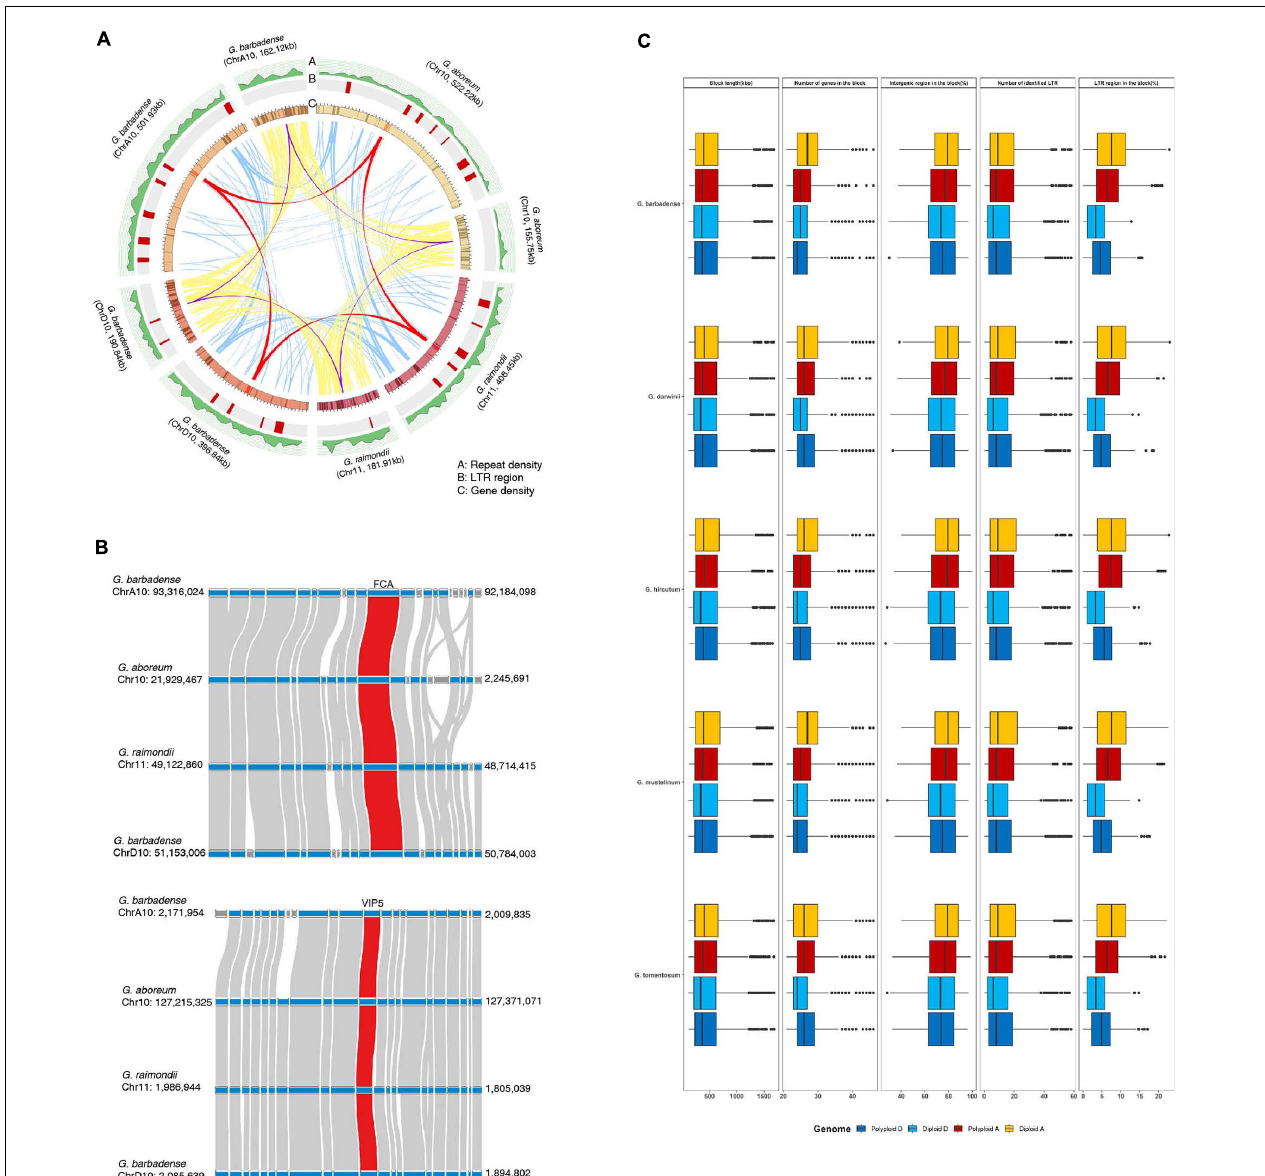
FIGURE 4 | Comparison of genomic structures near flowering-time genes in diploid and polyploid genomes. (A) Analysis of gene collinearity and genomic alterations between A and D genomes. (B) Investigation of microsynteny near the FCA and VIP5 genes. (C) Analysis of genomic variations in flowering-time genes and their flanking regions in diploid and polyploid